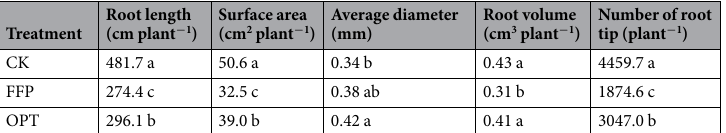
Table 4. Average N rate, total N uptake (TU N ), N partial factor productivity (PFP N ), N agronomic efficiency (AE N ) and N recovery efficiency (RE N ) of N managements across six sites in Jiangsu in 2008–2013.